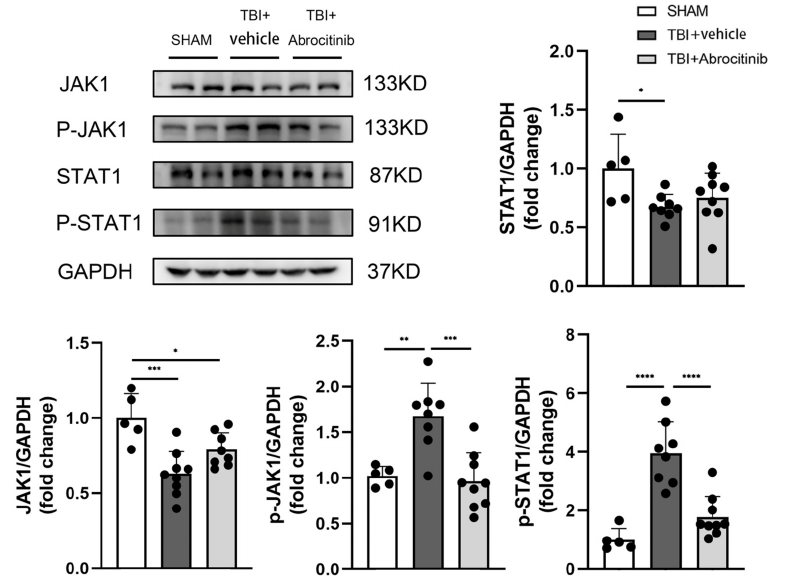
Figure 4. Effects of abrocitinib on the JAK1/STAT1 pathway. On the 1st day after TBI, JAK1 and STAT1 showed a dramatic increase in activation. After abrocitinib treatment, the activated JAK1 and STAT1 were significantly decreased, as shown in the WB results above and can be displayed through WB (n = 5–9, one-way ANOVA with Tukey’s post-hoc test). All data are shown as mean ± SD. * p < 0.05, ** p < 0.01, *** p < 0.001, **** p < 0.0001. 3.5. Abrocitinib Did Not Change Blood Counts after TBI To observe whether abrocitinib had effects on the hematopoietic system, peripheral blood counts were measured. As shown in Table 1, the numbers of white blood cells, red blood cells, platelets, and hemoglobin did not change evidently among the three groups. However, compared to the sham group, the number of neutrophils and the percentage of neutrophils were significantly increased in the TBI and TBI + abrocitinib groups.